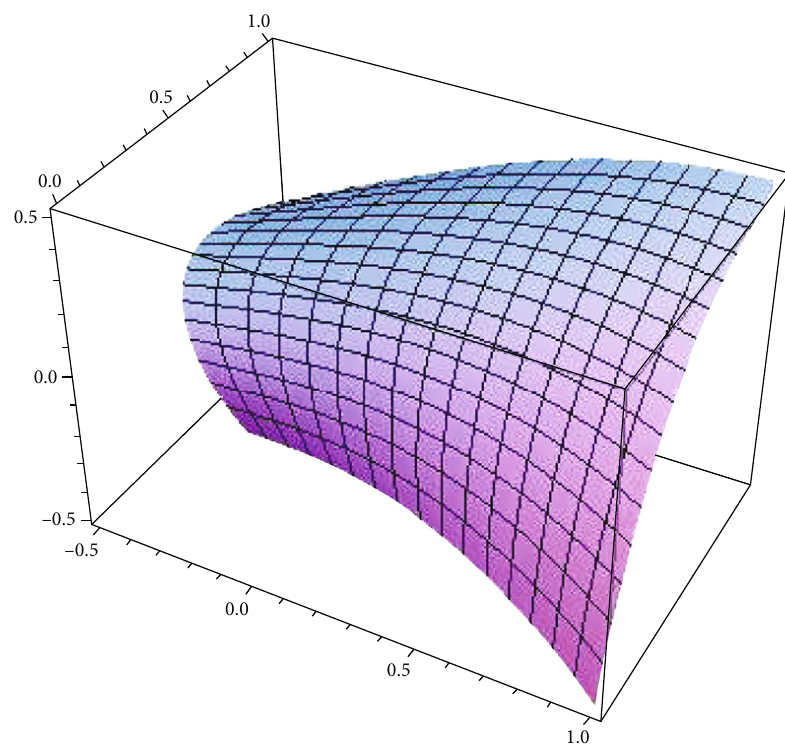
Figure 7: R -Coons patch (equation (25)) for the rational blending functions (equation (26)) for a = 0 .